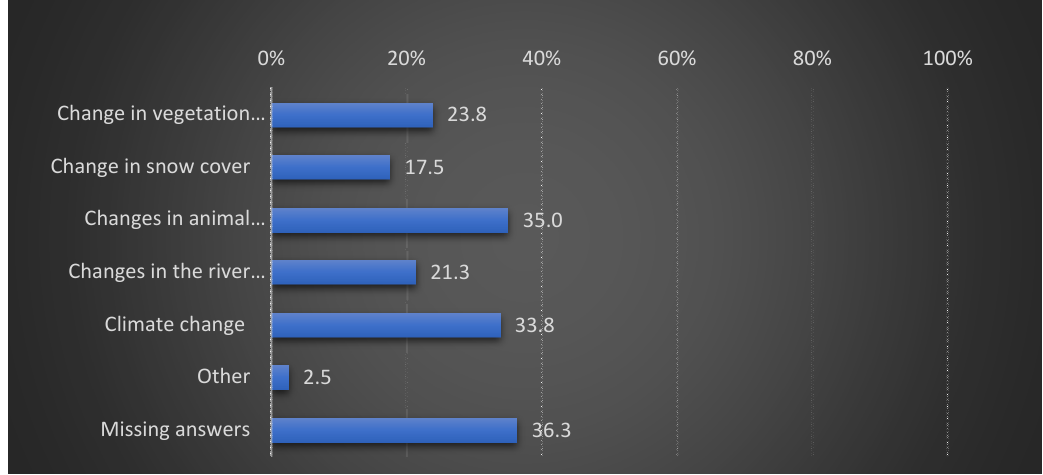
Figure 10. Visitor perceptions of changes in the environment (multiple answers were possible).